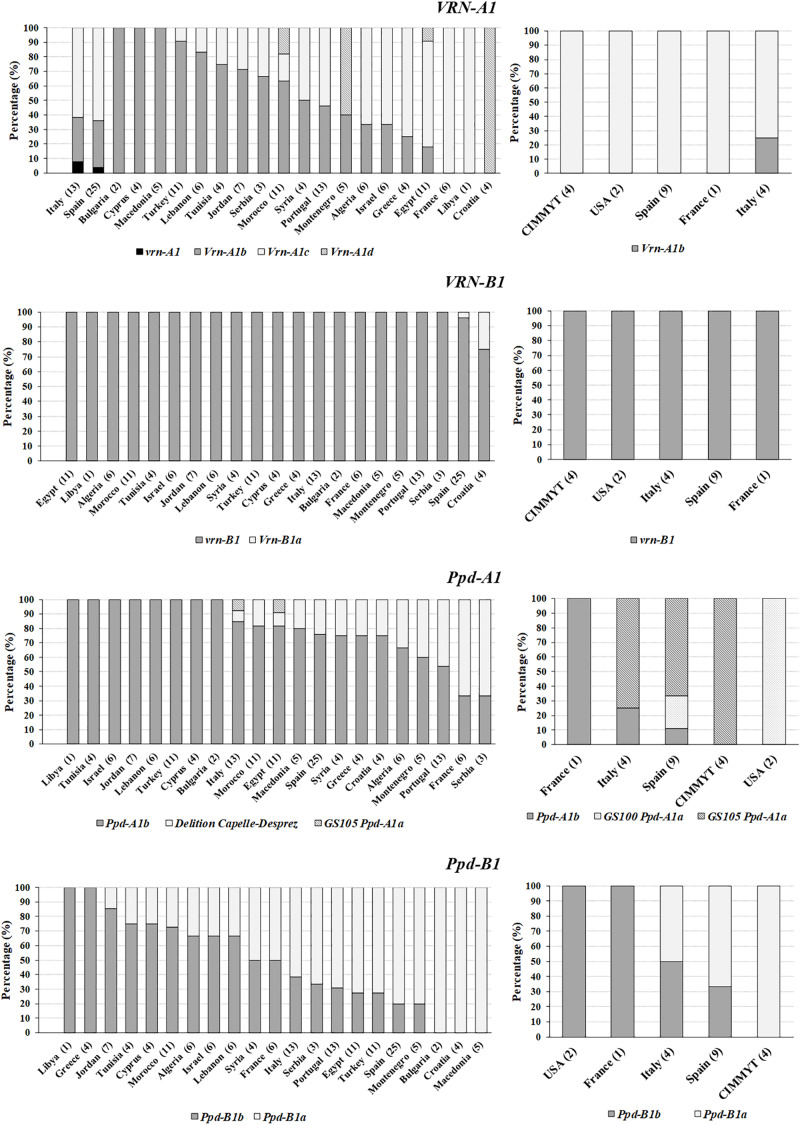
Distribution of the allele variant frequencies (%) for the vernalization and photoperiod sensitivity genes in a collection of durum wheat landraces (left) and modern cultivars (right) by their geographical origin. Within parentheses the number of entries by each origin.